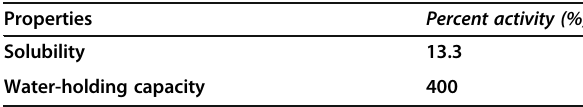
Table 2 Physical properties of L. paraplantarum KM1